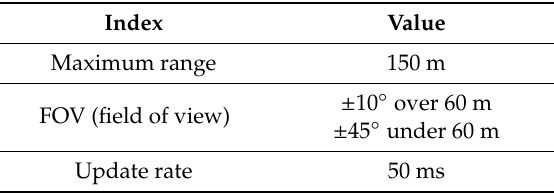
Figure 6. Test vehicle and logging environment. Table 3. Specifications of the radar sensor.